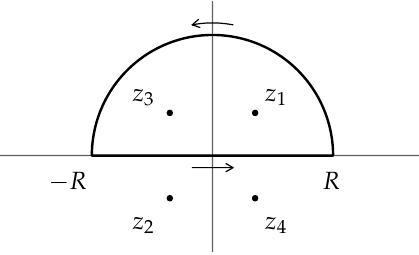
Figure 6. Integration contour for x <